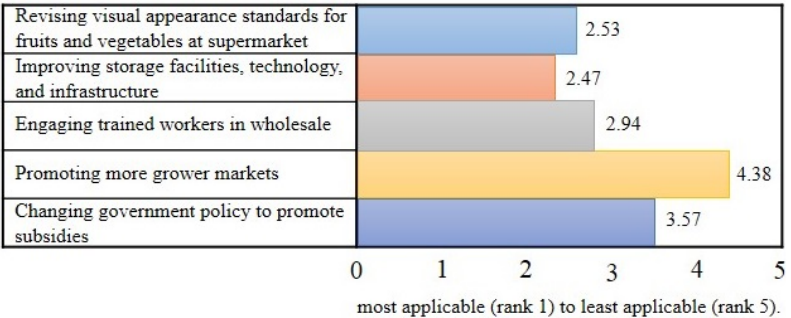
Figure 5. Food loss reduction categories and mean rankings produced from participant responses.